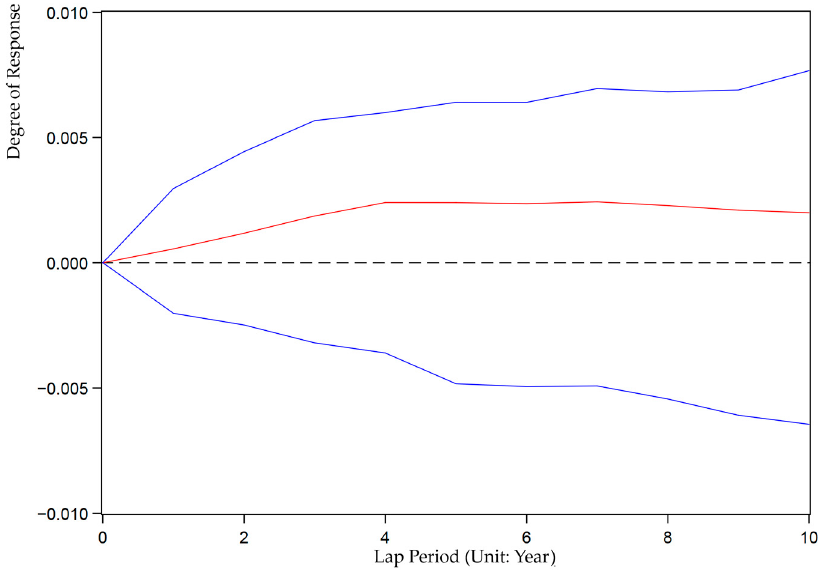
Figure 3. Impulse response of ULDI to GEE.